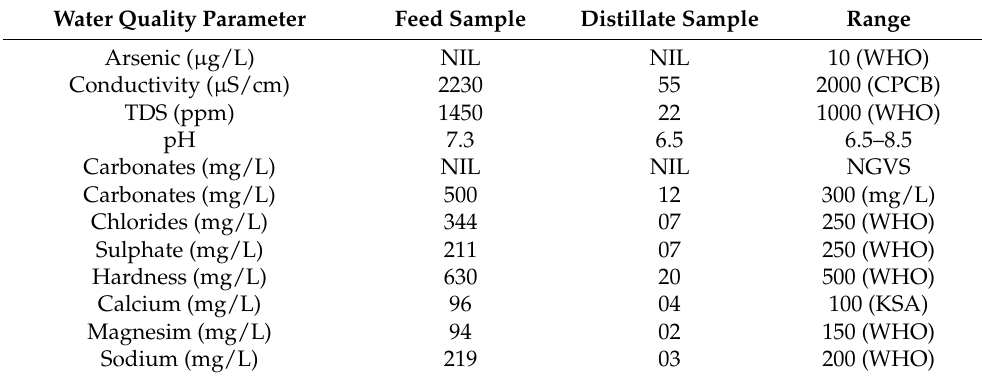
Table 3. Chemical composition test for water samples (The AQUA Solutions, RYK). Water Quality Parameter Feed Sample Distillate Sample Range Arsenic ( µ g/L) NIL NIL 10 (WHO) Conductivity ( µ S/cm) 2230